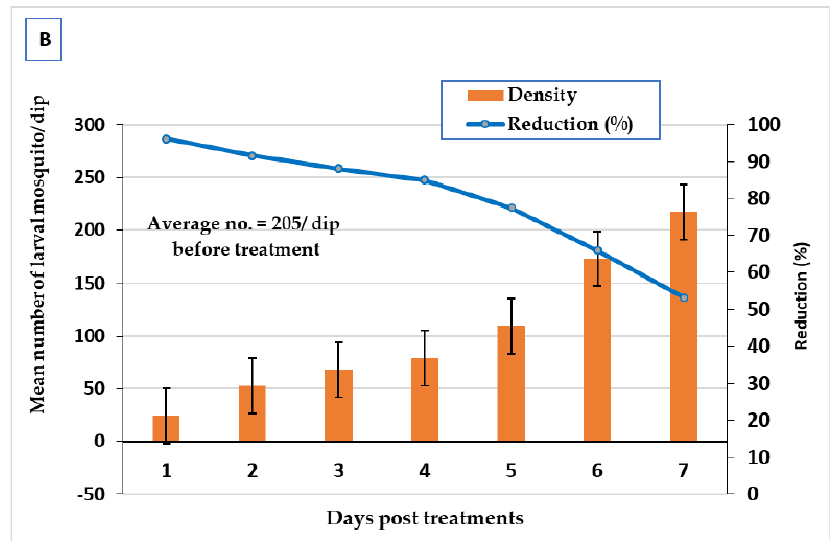
Figure 8. Field efficacy of fennel oil ( A ) and its Mg-LDH ( B ) treated at dose of LC 95 X2 (3978.6 and 2003.5 ppm, respectively, in larval breeding sites.